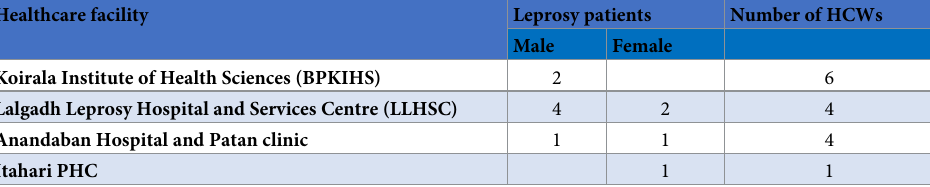
Table 1. Number of patients and HCWs interviewed by